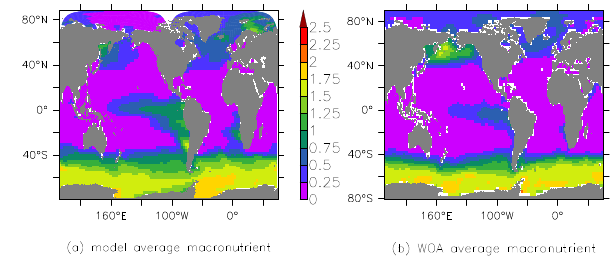
Figure 6. Comparison of macronutrient concentrations (cid:16) (cid:17) 1 PO 4 + NO 3 , (a) modeled using GFDL CM2Mc with BLING 2 16 biogeochemistry and (b) observed annual mean field, from World Ocean Atlas 2013 nitrate and phosphate data sets (Garcia et al., 2014). Concentration in